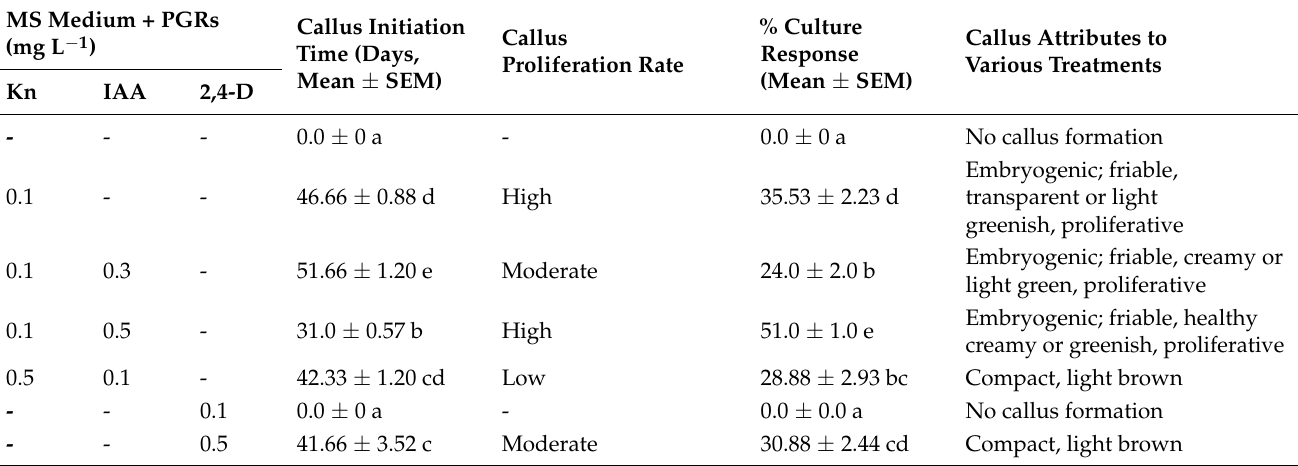
Table 2. Effects of Kn, IAA, and 2, 4-D on embryogenic and non-embryogenic callus formation from the immature and mature seeds of Aconitum violaceum